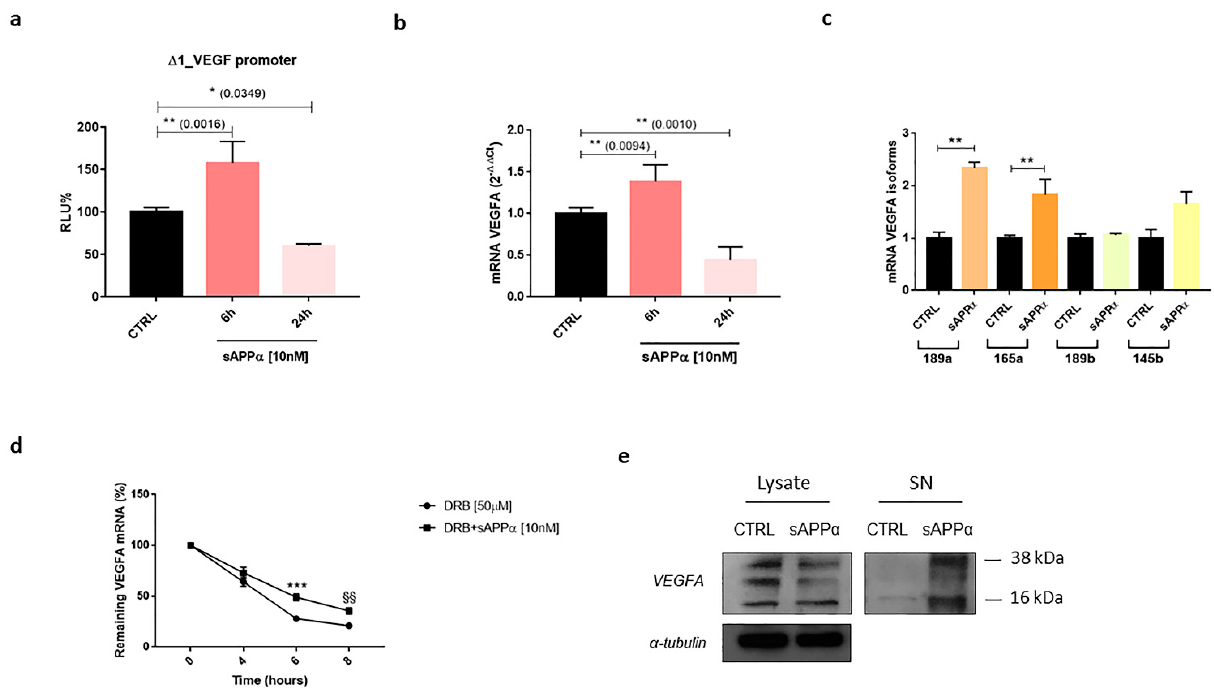
Figure 5. Effects of sAPP α treatment on VEGF expression. SH-SY5Y cells were treated with 10 nM sAPP α for 6 or 24 h. ( a ) SH-SY5Y cells transiently transfected with ∆ 1_VEGF luciferase-reporter plasmid and treated with sAPP α were lysed and luciferase activity was measured as previously described [141]. Luciferase activity is expressed as RLU% normalised to non-treated construct (set as 100%). ( b , c ) Evaluation of sAPP α -mediated VEGFA transcriptional regulation. mRNA levels were assessed by qPCR and normalised on RPL6 ( b ) or the respective VEGFA isoform (employed primers described in [206]) ( c ). ( d ) Evaluation of sAPP α effects on VEGFA mRNA stability. SH-SY5Y cells were pre-treated with 50 µM DRB 53-85-0 (a classic RNA polymerase II inhibitor), then treated with 10 nM sAPP α for 0, 4, 6 or 8 h. RNA was extracted and reverse-transcribed as previously described [141]. mRNA levels were assessed by qPCR. Results are expressed as a percentage of the initial steady-state VEGFA mRNA levels. ( e ) Evaluation of VEGF protein levels in cell lysates and supernatants (SN). The image is a representative Western blot. Results are expressed as mean ± SEM, n = 3 independent experiments. Statistical analysis was performed with one-way ANOVA followed by Dunnett’s multiple comparison test ( a – c ), with Bonferroni multiple comparison test ( d ) or Student’s t -test ( e ) with * p < 0.05 and ** p < 0.01 vs. control (CTRL), *** p < 0.001 DRB vs. DRB + sAPP α (6 h) and §§ p < 0.01 DRB vs. DRB + sAPP α (8 h). Statistical signi fi cance is detailed in the respective fi gure panel.